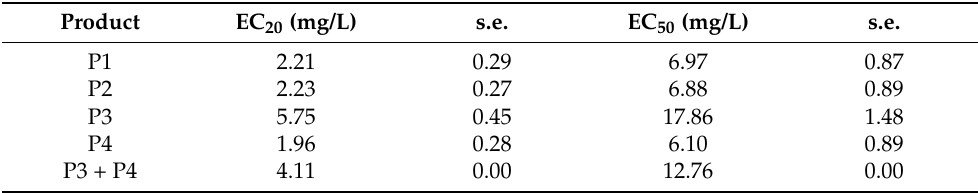
Table 3. Toxicity of the four foaming agent products (P1, P2, P3, P4 and P3 + P4) evaluated by the V. fischeri test; results are expressed as EC 20 and EC 50 ± standard errors (s.e.) at 30 min of exposure.